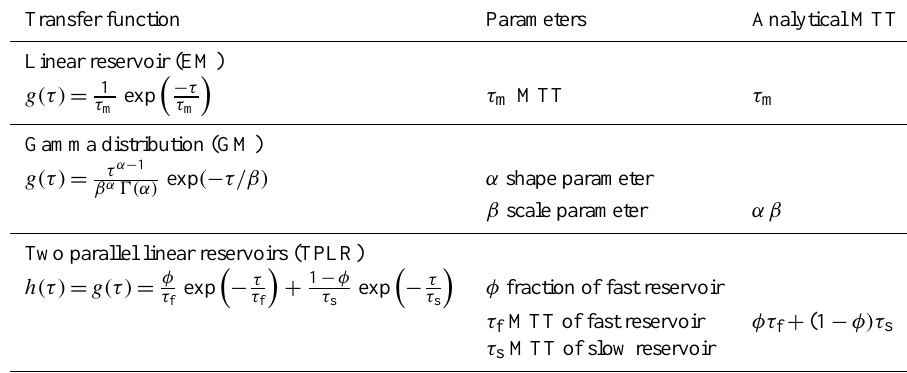
Table 2. Overview of transfer functions with specification of the parameters and analytical